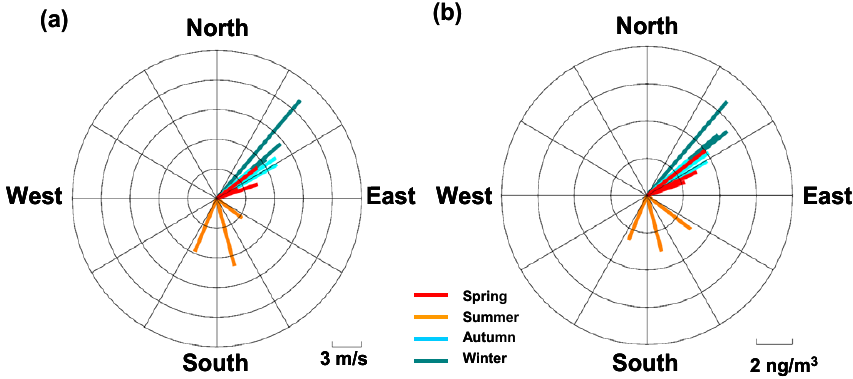
560 Fig. 5. Rose diagrams of (a) averaged wind vector and (b) GEM values with wind direction between 2003 and 2005 over the northern SCS.